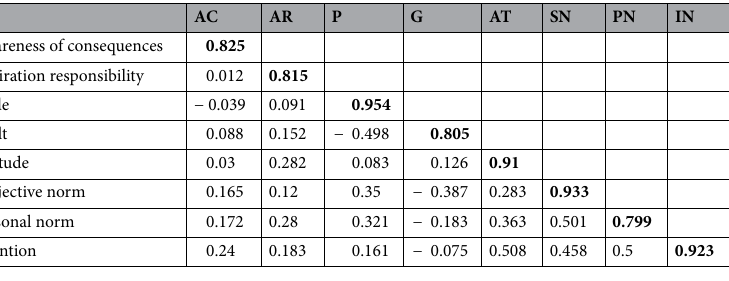
Table 2. Correlation between constructs and discriminant validity. The square root AVE of each latent variable is